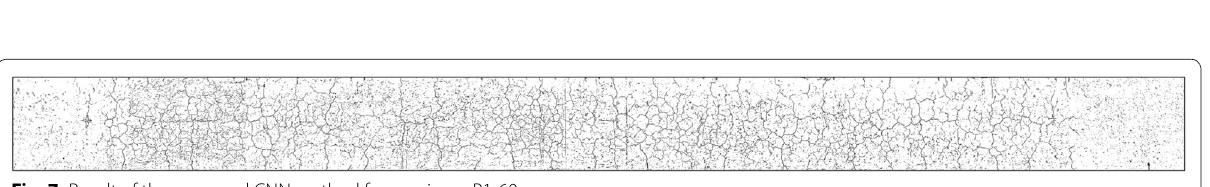
Fig. 7 Result of the proposed CNN method for specimen